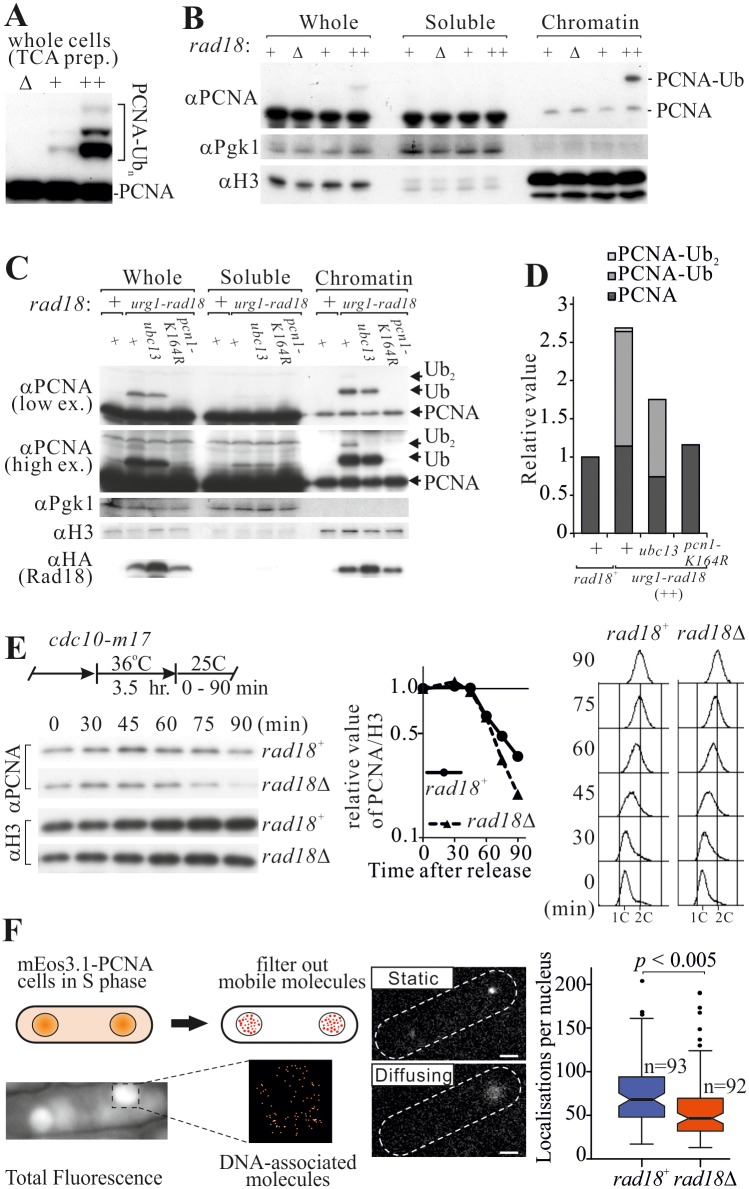
PCNA ubiquitylation influences PCNA chromatin association.(A) PCNA ubiquitylation levels in log phase cells when Rad18 is absent (Δ), expressed normally (+) or upregulated in Purg1-rad18 cells (++). Ubiquitylation was assessed following protein extraction in denaturing condition (TCA prep). (B) PCNA chromatin association. The cells shown in panel A expressing different levels of Rad18 and thus harbouring distinct level of PCNA ubiquitylation were analysed for PCNA chromatin association. Pgk1 (a soluble cytosolic protein) and histone H3 were used as controls. (C) Dependency of chromatin association on PCNA-K164 and Ubc13. An equivalent experiment as shown in panel B for pcn1-K164R and ubc13 mutant backgrounds. (D) Quantification of the modified and unmodified PCNA from C. (E) Chromatin association of PCNA during S phase progression. Top left, experimental scheme: cells were synchronised at the G1/S boundary by temperature shift and PCNA chromatin association (bottom left panel) and cell cycle profiles (right) monitored at the indicated time points after release into S phase. The relative amounts of chromatin-associated PCNA were quantified (centre) (F) Quantification of DNA-associated PCNA by single molecule PALM imaging. Top left: schematic showing how motion blurring filters out mobile molecules. Bottom left: example of the visualisation of only the DNA-associated molecules. Middle: example of static localised molecule (top) and the typical signal from a diffusing molecule (bottom). Right: box plots of the numbers of visualised immobile PCNA molecules in the S phase nuclei of the indicated strains. Bi-nucleate (S phase) mEos3-pcn1 cells (expressing mEos3-tagged PCNA) were imaged and mEos3-PCNA localisations quantified per nucleus.